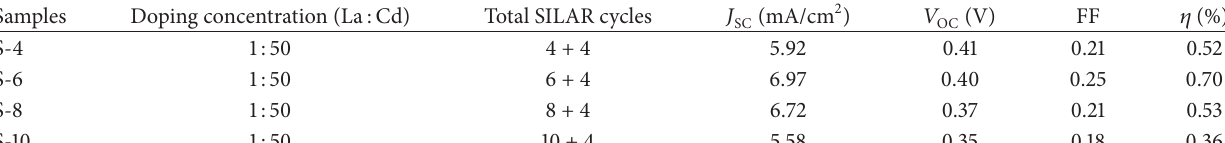
Table 2: Experiment parameters and sample calibration of different SILAR cycles of La doped CdS.